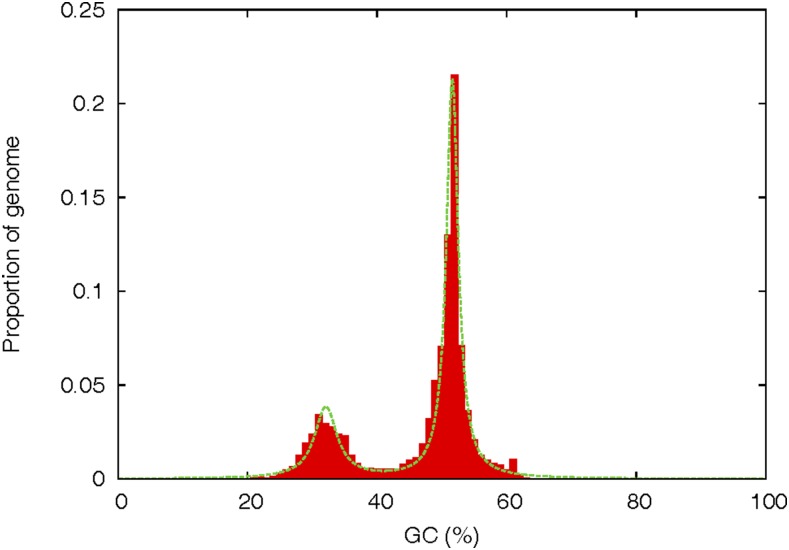
OcculterCut v1 GC% plot of the P. teres f. teres 0-1 genome. A bimodal distribution is observed in which genome segments fall into the high GC% category (41–100%) or the low GC% category (0–41%). The OcculterCut calculated cut off for distinguishing low and high GC% content in 0-1 is 41%.